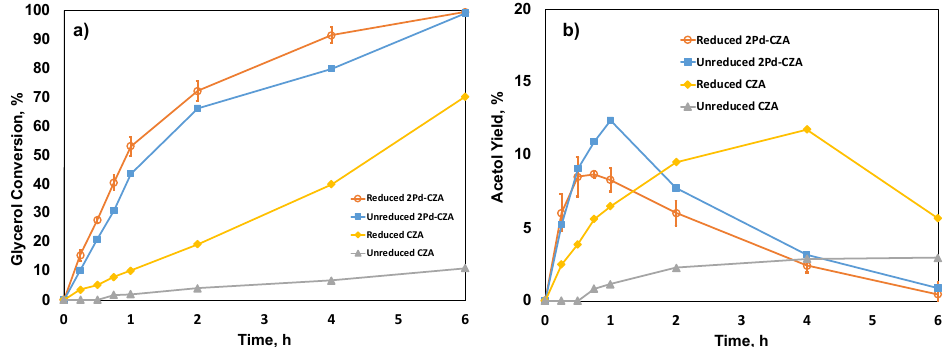
Figure 7. Effect of Pd on the unreduced CZA catalytic activity and compared with the reduced catalysts in glycerol hydrogenolysis with in situ hydrogen from methanol steam reforming: ( a ) glycerol conversion; ( b ) acetol yield. Reaction conditions: 220 °C, 1.5 MPa N 2 , 20 wt% glycerol, wa- ter/methanol molar ratio = 1.2, 3 wt% catalyst with respect to total feed mixture, 6 h reaction time, 500 RPM. CZA: Cu/Zn/Al (molar) = 35/35/30. Error bars: 95%